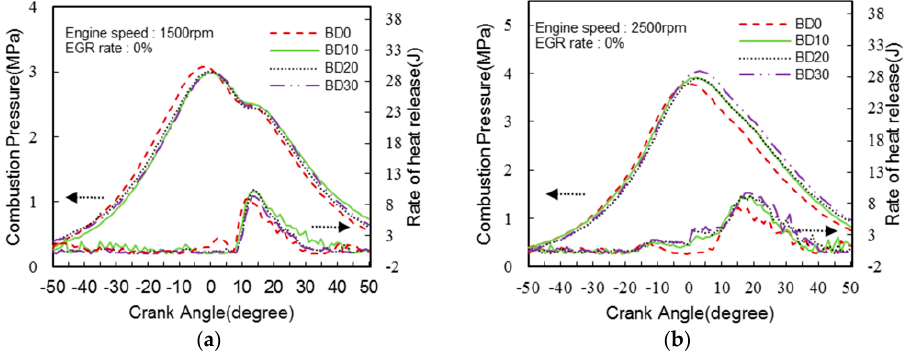
Figure 11. Combustion pressures and rate of heat releases of blend fuels at ( a ) 1500 rpm and ( b ) 2500 rpm. EGR: exhaust gas recirculation.